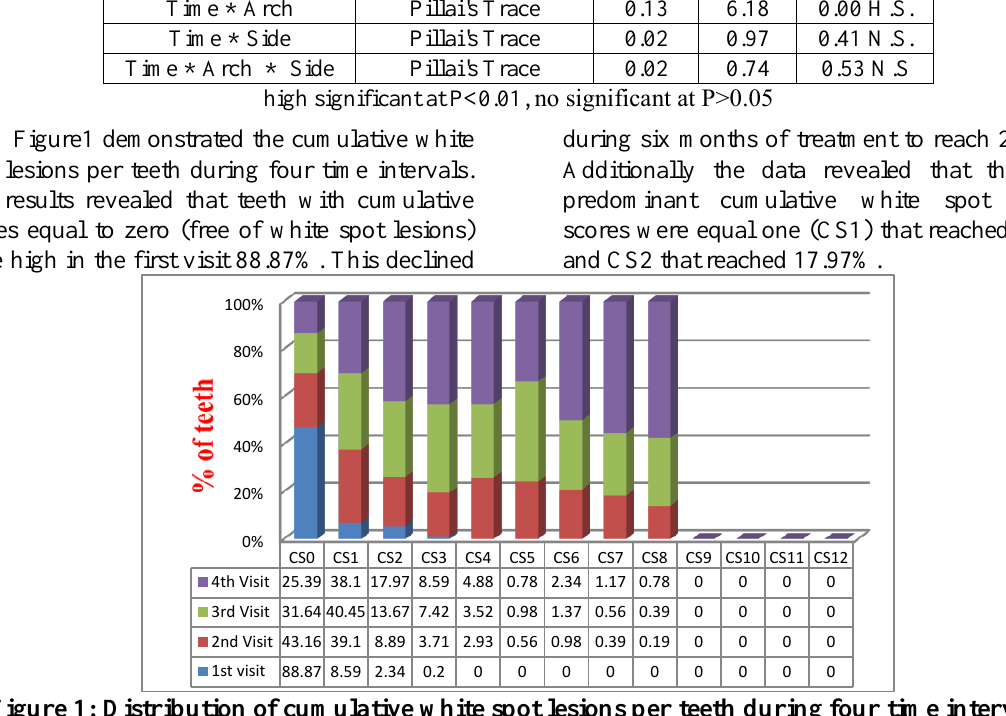
Figure 1: Distribution of cumulative white spot lesions per teeth during four time intervals Figure2 illustrated the distribution of white spot lesions among teeth in maxillary and mandibular arches during four time intervals.